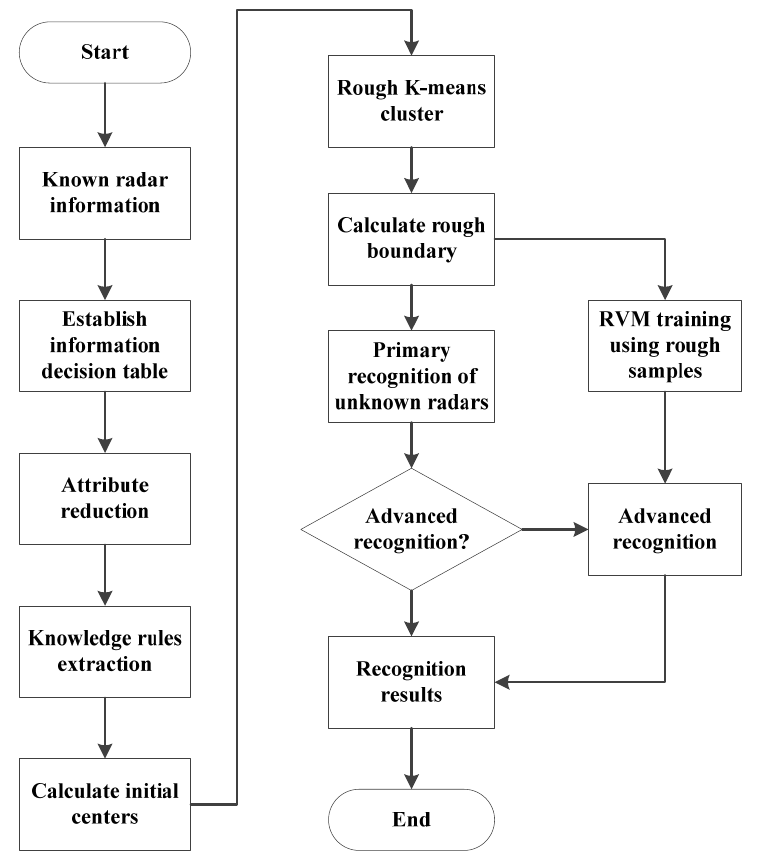
Figure 2. Flow chart of the hybrid radar emitter recognition approach proposed in this paper. First of all, samples are recognized by the primary recognition, which can classify linearly separable samples and pick up those linearly inseparable samples to be classified in the advanced recognition using relevance vector